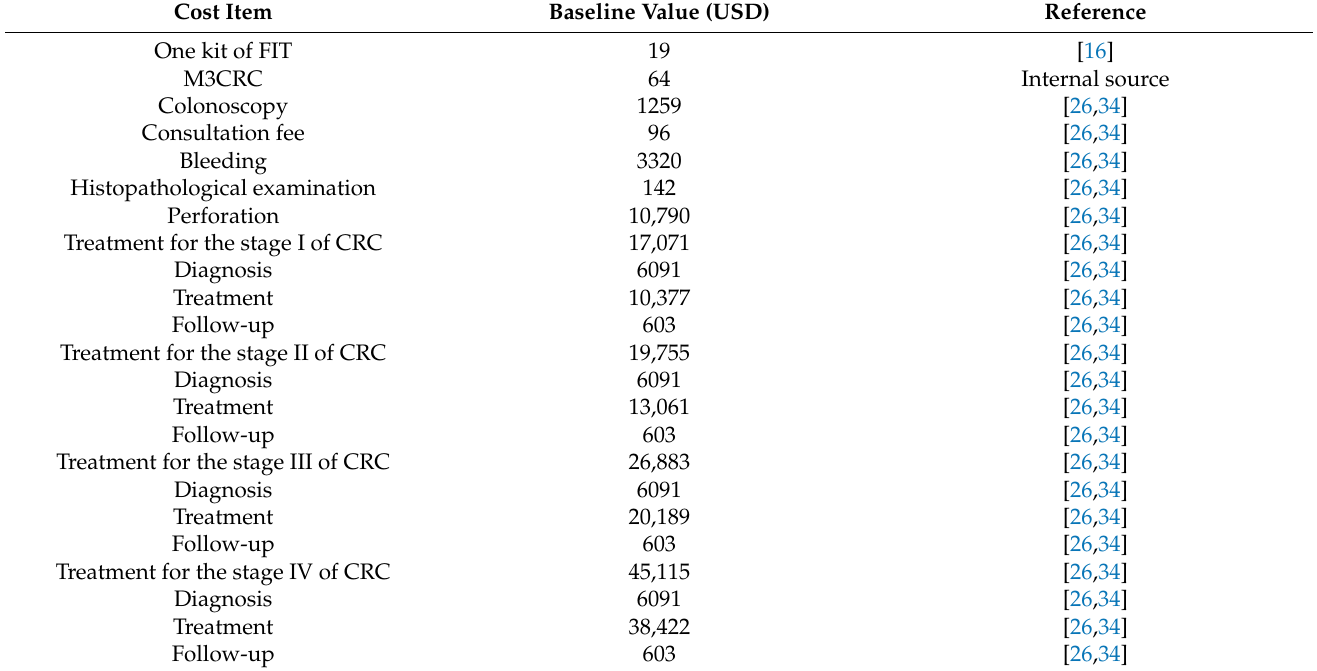
Table 2. Estimates for the costs based on different screening strategies and treatment